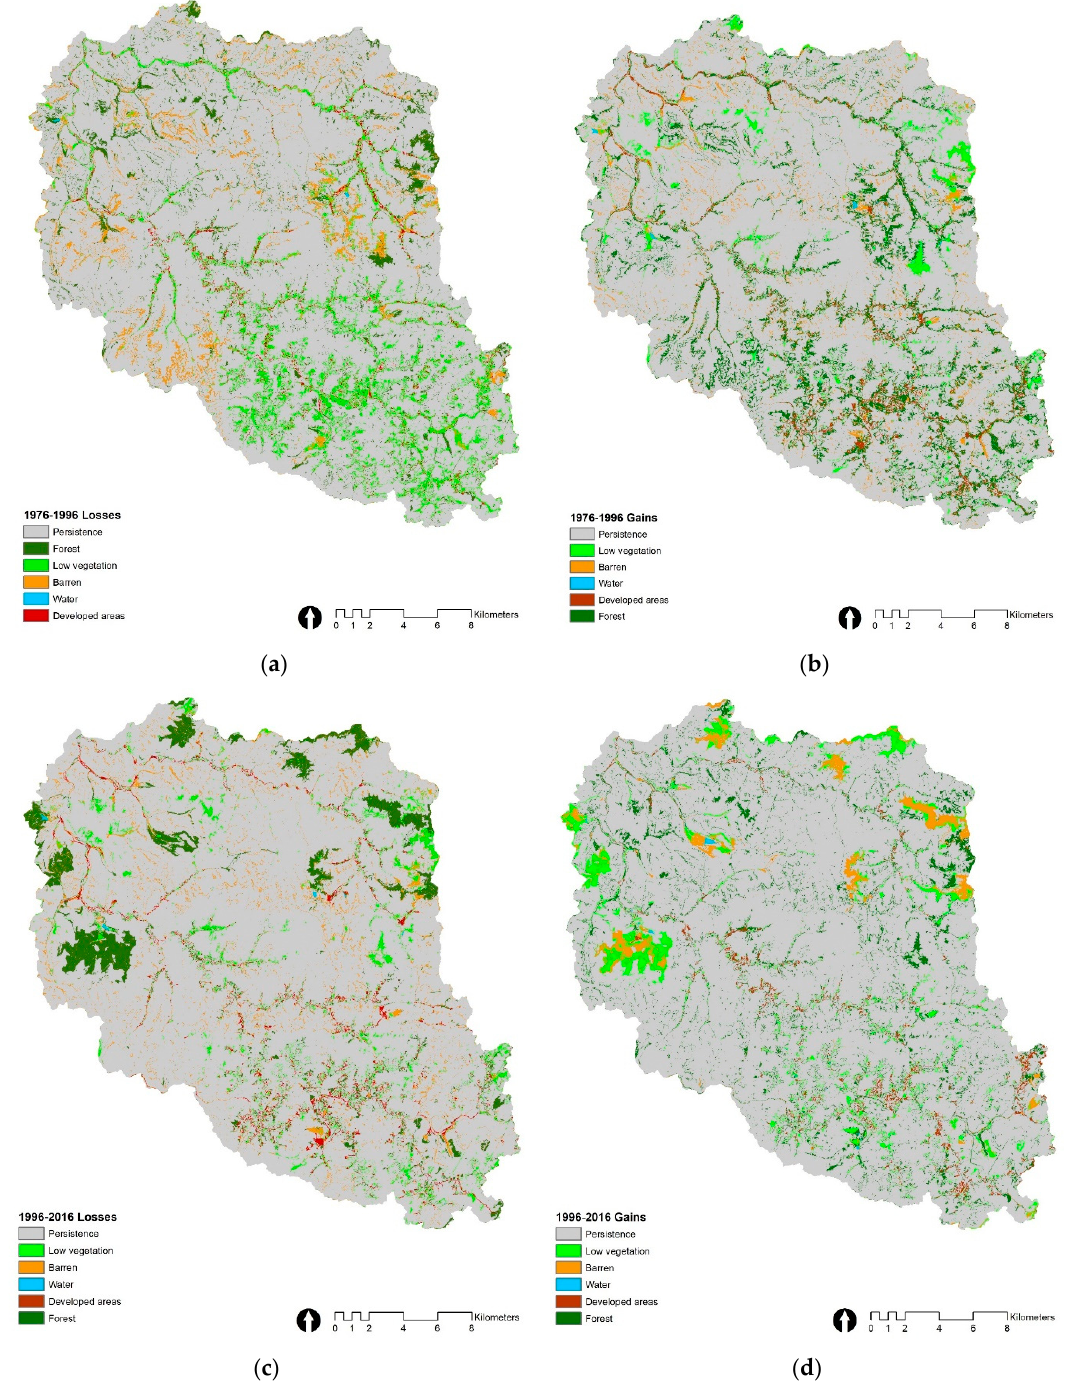
Figure 8. Maps show areas of gains and losses for each LC class during the two time intervals: ( a ) areas of losses from 1976–1996; ( b ) areas of gains from 1976–1996; ( c ) areas of losses from 1996–2016; ( d ) areas of gains from 1996–2016. Table 10. Total Change, Net Change, and Swap values for the two intervals. Values are in hectares.